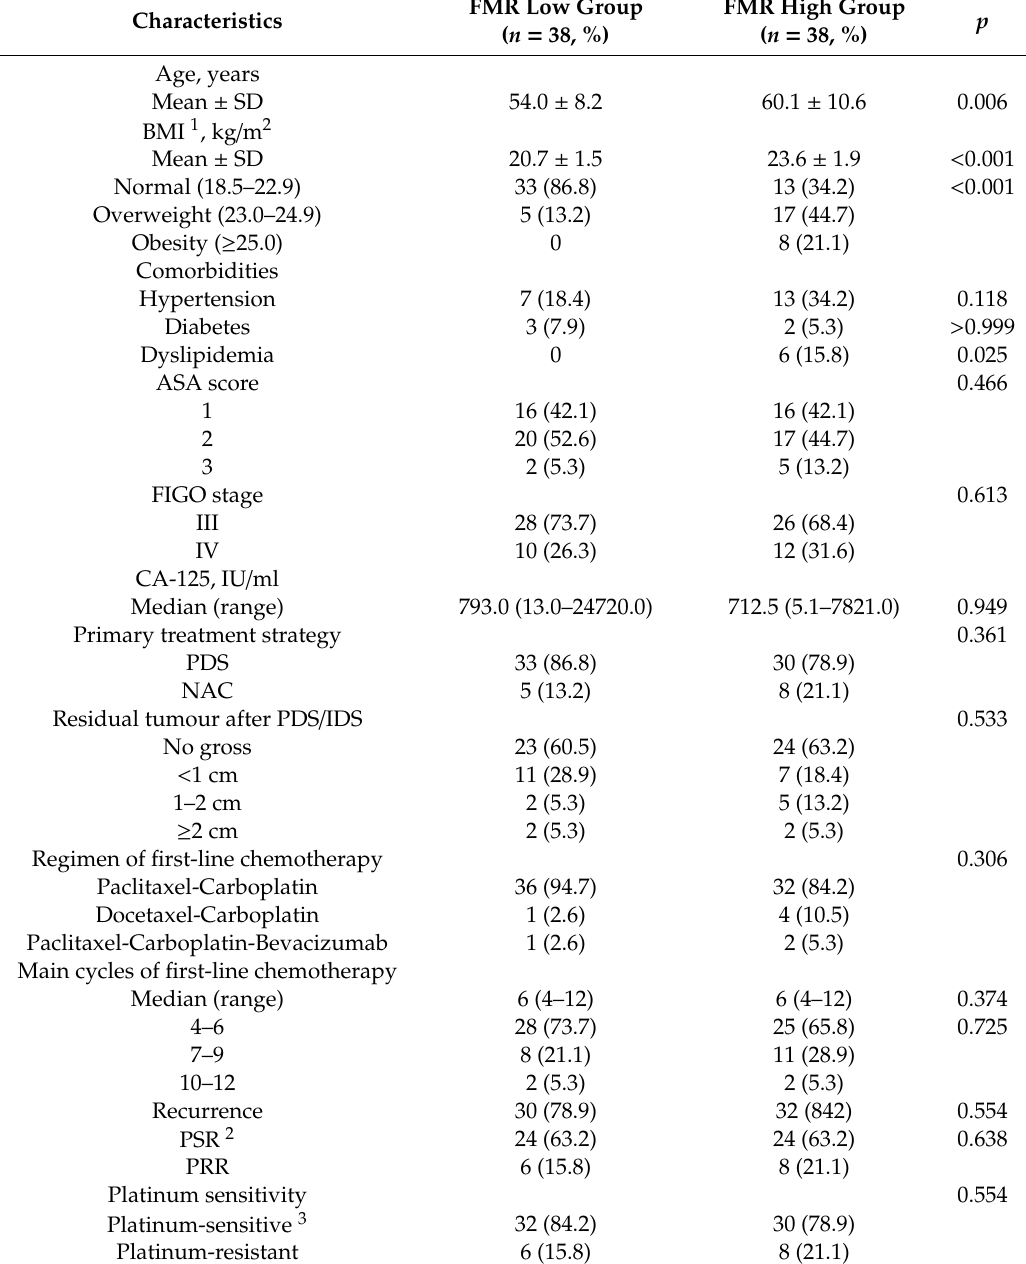
Table 4. Clinicopathologic characteristics of sarcopenia patients. 1 In this study, underweight patients (BMI < 18.5 kg / m 2 ) were excluded in analysis. 2 PSR was defined as relapse ≥ 6 months after completion of taxane- and platinum-based chemotherapy, whereas PRR as relapse < 6 months. 3 In addition to PSR, the patients who completed taxane- and platinum-based chemotherapy and did not experience disease recurrence during at least six months of follow-up period were considered